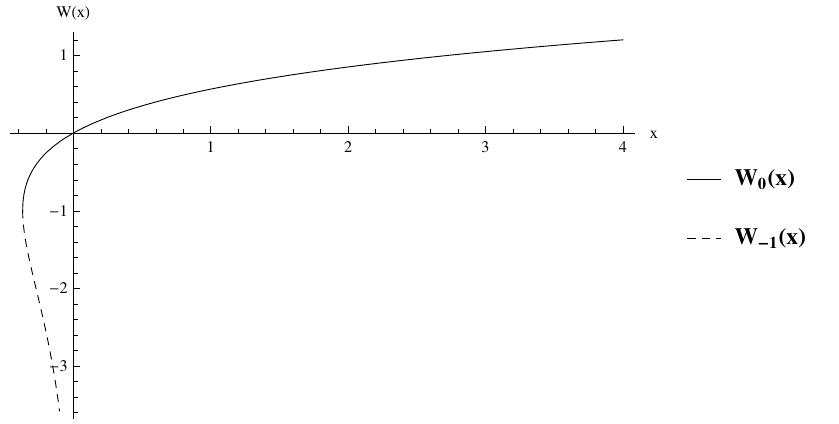
Figure 1. Lambert